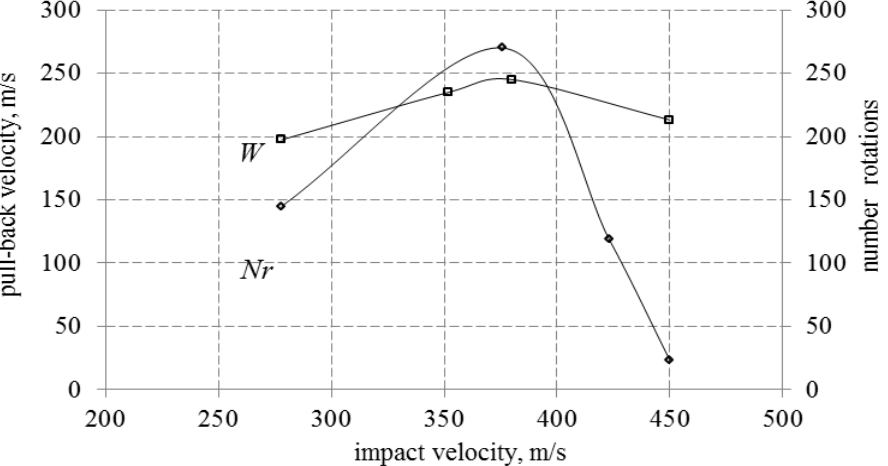
Figure 8. Dependencies of spall strength, W , and density of rotational cells. On the impact velocity for 2Cr-2Ni-Mo-V steel 4.